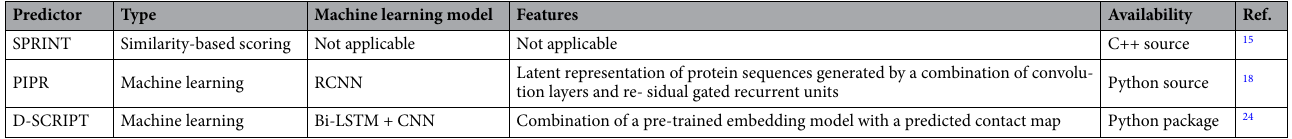
Table 2. State of the art sequence-based PPI